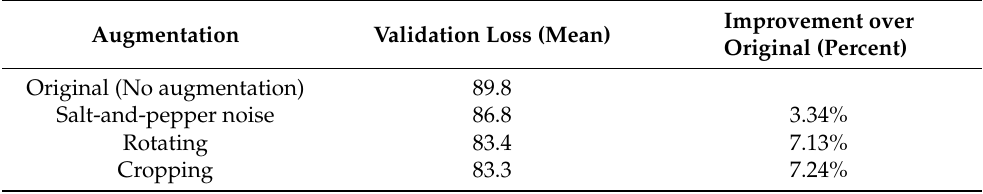
Table 4. Effects of the augmentations. The validation loss is the mean of three separate